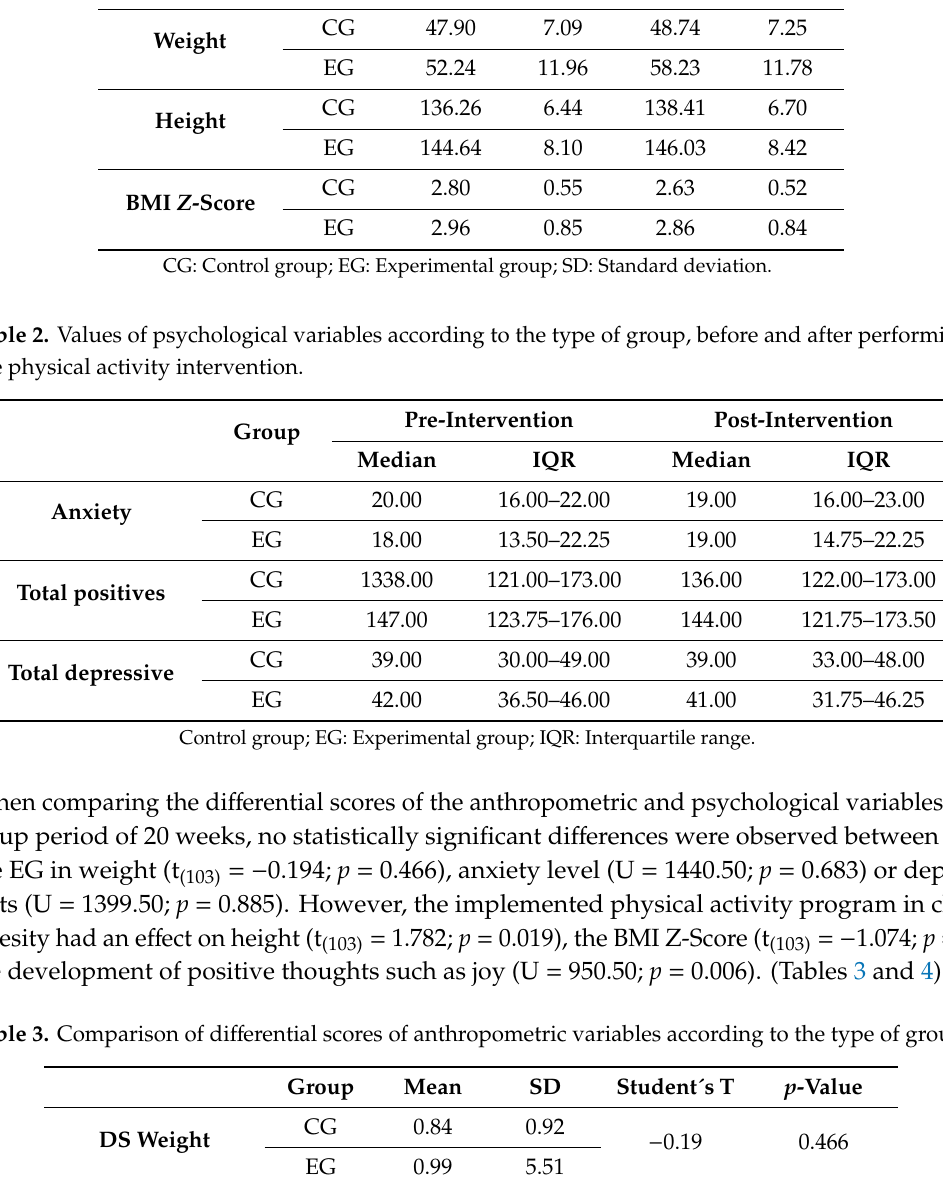
Table 1. Values of anthropometric variables according to the type of group, before and after of performing the physical activity intervention. Pre-Intervention Post-Intervention Group